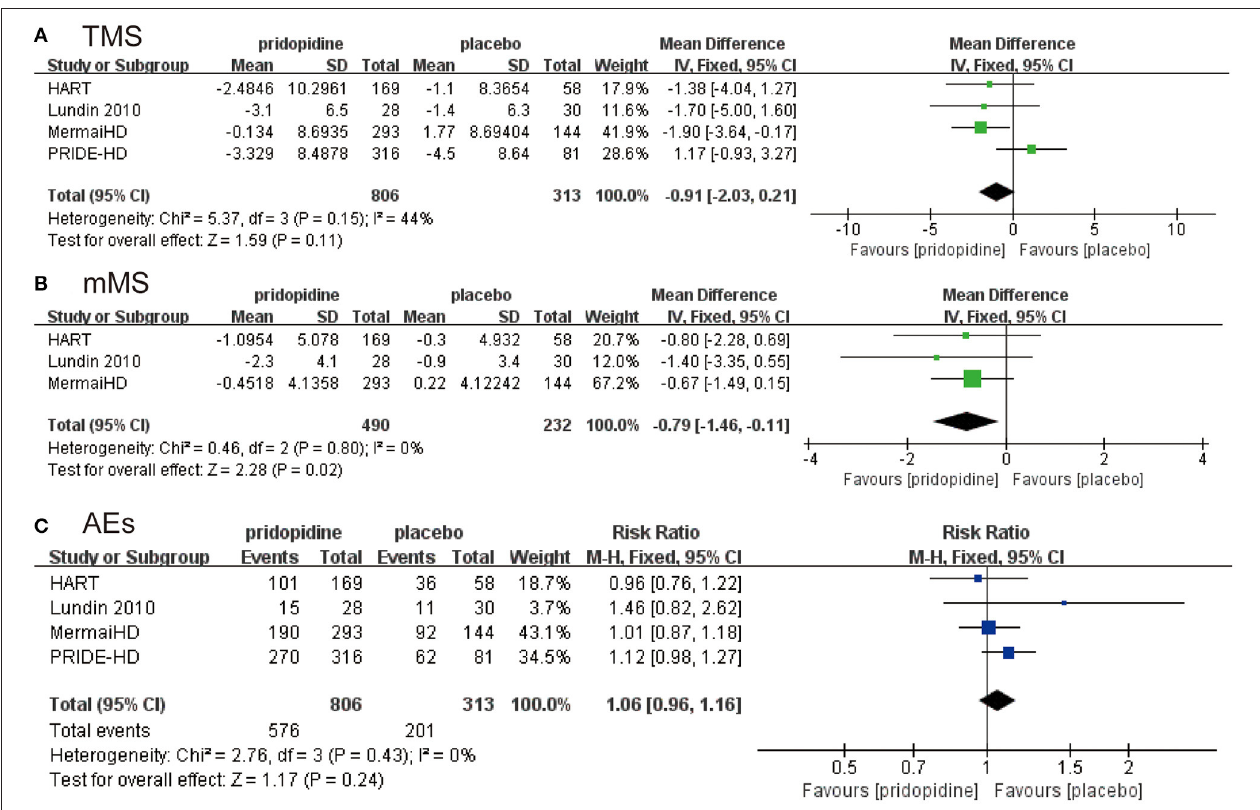
FIGURE 2 | The pooled relative risk of efficacy outcome. The blue diamond indicates the estimated risk ratio (95% confidence interval), and the green diamond indicates the mean difference (95% confidence interval) for all patients together. (A) TMS. (B) mMS. (C) adverse